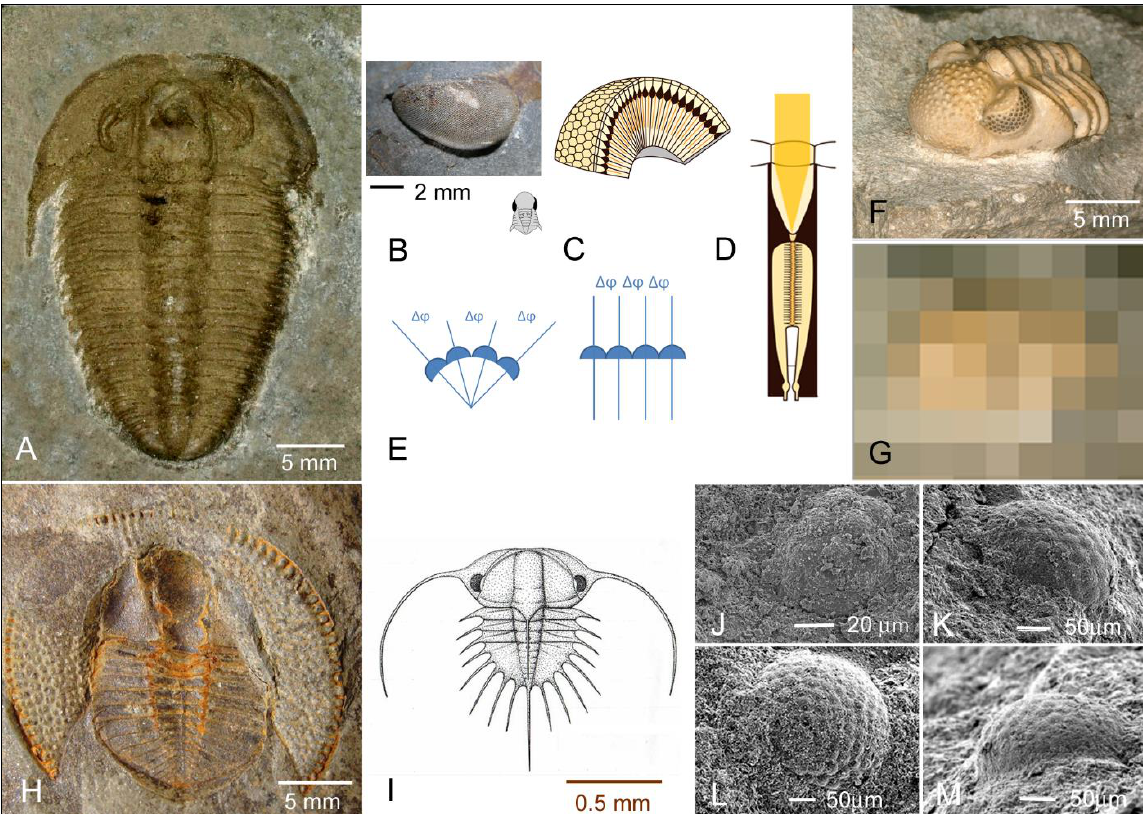
Figure 1. Trilobite compound eyes. (A) Irina oculata. Ordovician E2, Krasnojarsk, Russia, with reniform holochroal eyes. (B) Holochroal compound eye of the trilobite Pricyclopyge prisca, Ordovician, Bohemia (insert). (C) Schematic drawing of a compound eye. (D) Schematic drawing of how an apposition compound eye functions. (E) Optical axes and the fineness of scanning. (F) Phacopid trilobite Geesops schlotheimi Middle Devonian, Auberg/Gerolstein, Germany. Note the schizochral eye with widely separated lenses. (G) E seen in an appositional-like mode with 63 facets, comparable to the specimen in E. (H) Declivolithus alfredi, Ordovician, El Kaid Errami, Morocco. Blind trilobite that lived in deep waters. (I) Ctenopyge ceciliae, tiny trilobite, Ordovician, Röstånga (Skane), Sweden. Probably the first planktonic trilobite. (J-M) Ontogenetic sequence of compound eyes of C .